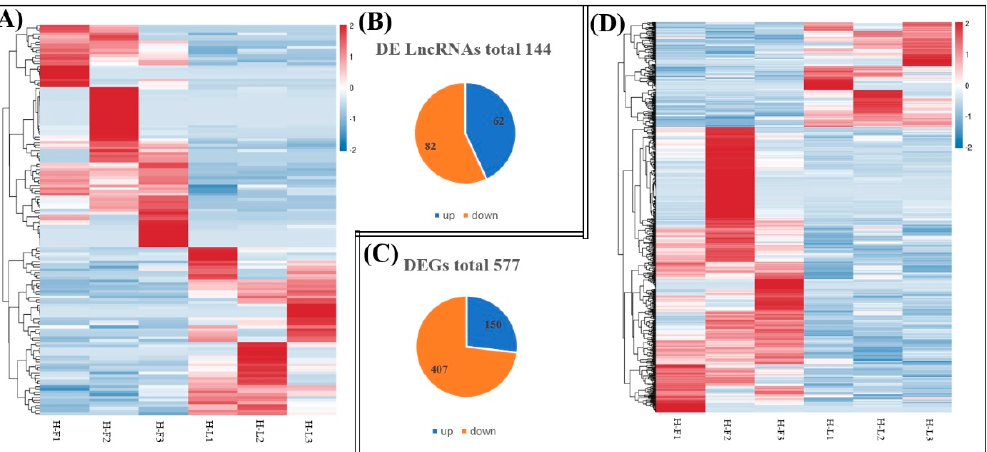
Figure 3. Comparisons of the number of DE lncRNAs and DE genes (DEGs) in H-F and H-L groups. ( A ) The hierarchical cluster of DE lncRNAs. ( B ) Total number of upregulated and downregulated DE lncRNAs in each comparison. ( C ) Total number of upregulated and downregulated DEGs in each comparison. ( D ) The hierarchical cluster of DEGs.